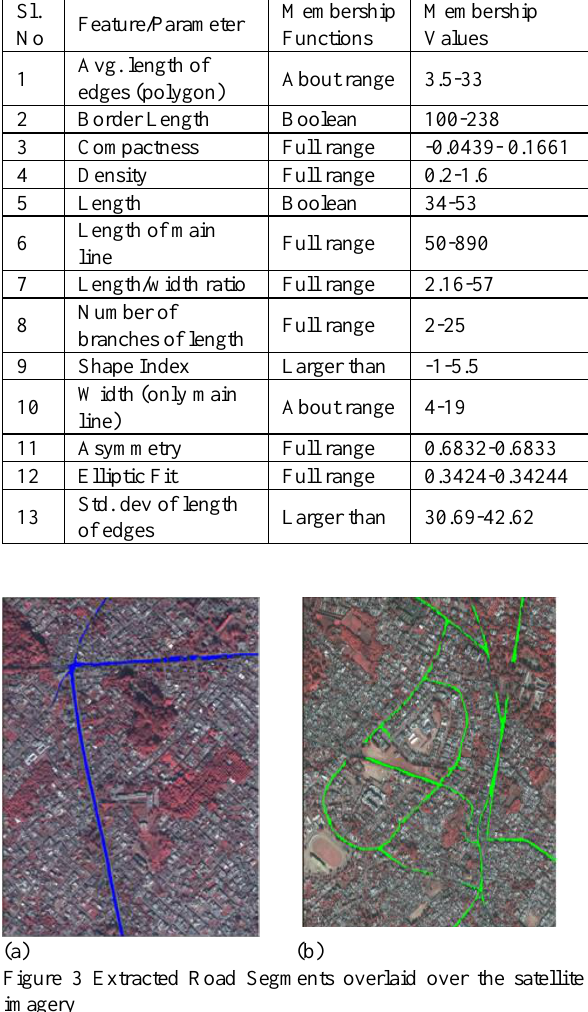
Table 1 Image Object Parameters with Membership Functions